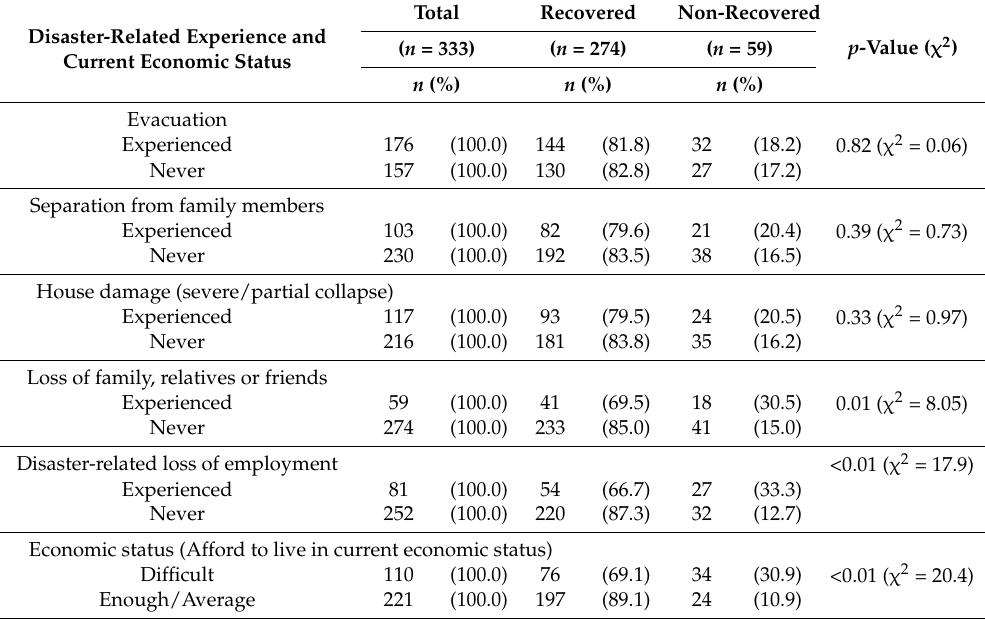
Table 3. Disaster-related experience and current economic